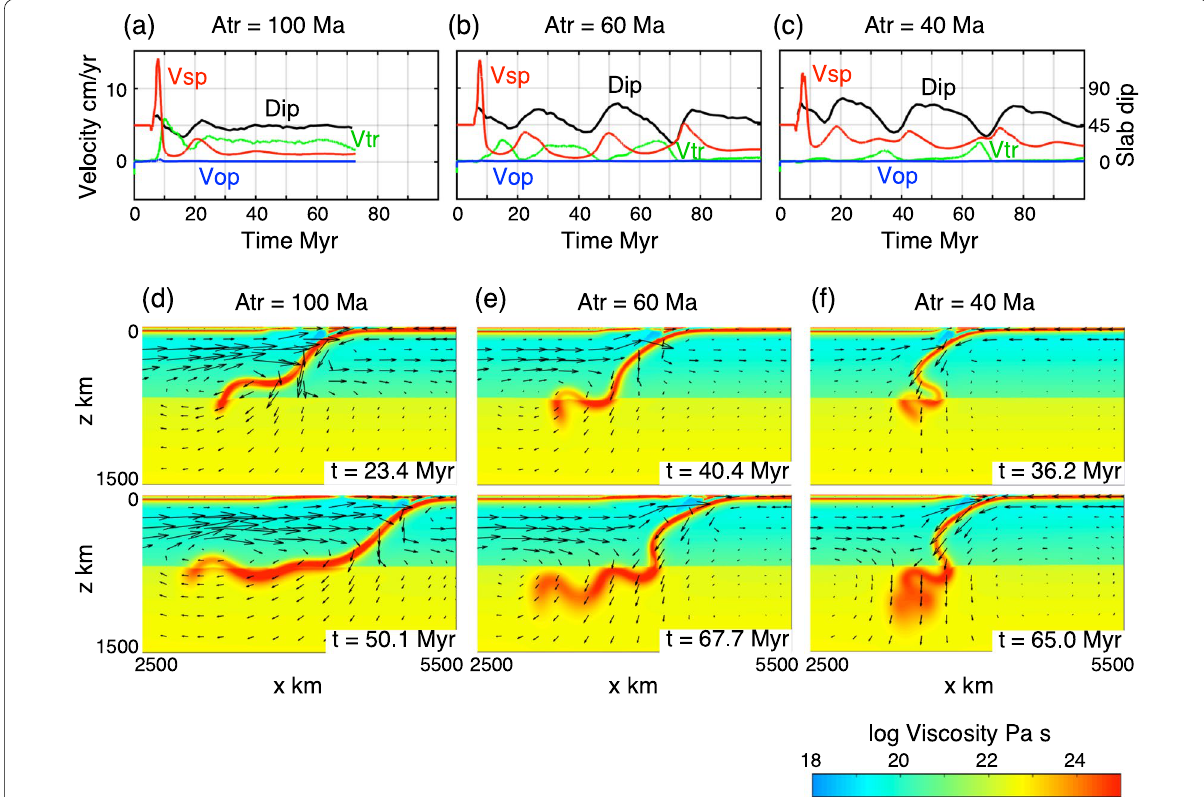
Fig. 5 Results for case 4 a , d with A tr Changes in velocities of the subducting plate ( V sp ), the overriding plate ( V op ) and the trench ( V tr ) combined with the average dip angle of the slab surface (Dip) measured in the depth range of 200–300 km. d – f Slab geometries. The distribution of effective viscosity is shown by different colors and arrows indicate the velocity